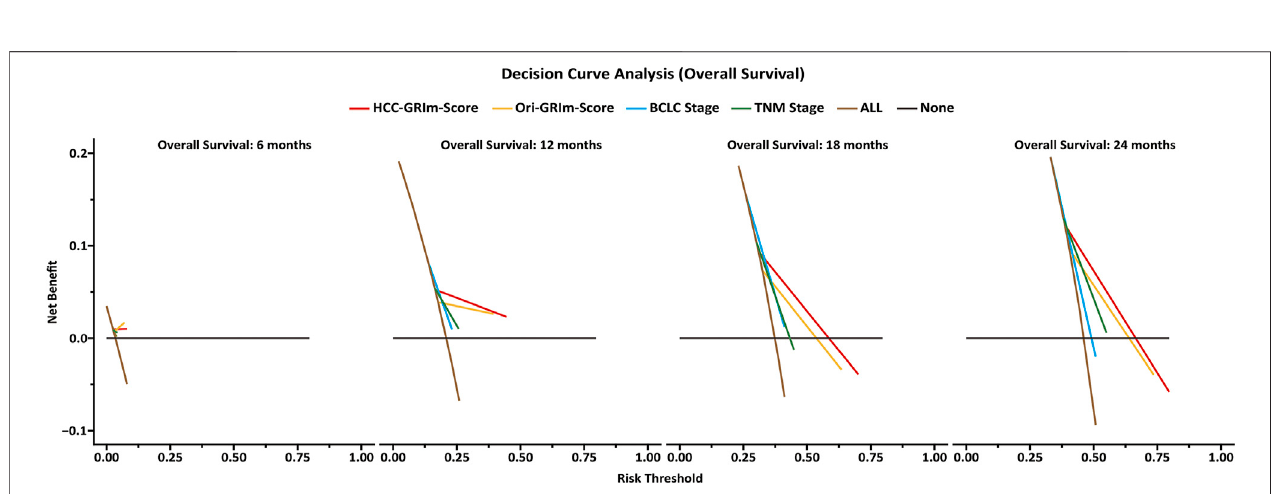
FIGURE 4 | Decision-curve analysis (DCA) plot depicting the standardized net bene fi t among HCC-GRIm-Score, Ori-GRIm-Score, TNM, and BCLC staging system at 6, 12, 18, and 24 months. HCC, hepatocellular carcinoma; TNM, tumor, node and metastasis; BCLC, Barcelona clinic liver cancer.